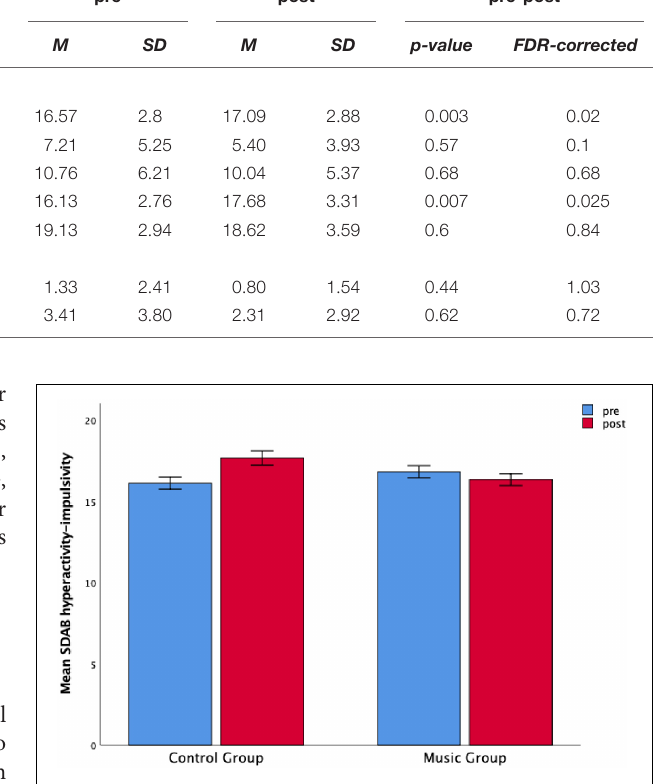
FIGURE 3 | The control group was associated with an increase in hyperactivity scores that was not found in the music group. Children’s mean scores as a function of Time (pre-test and post-test) and Group (music and control). Error bars are standard